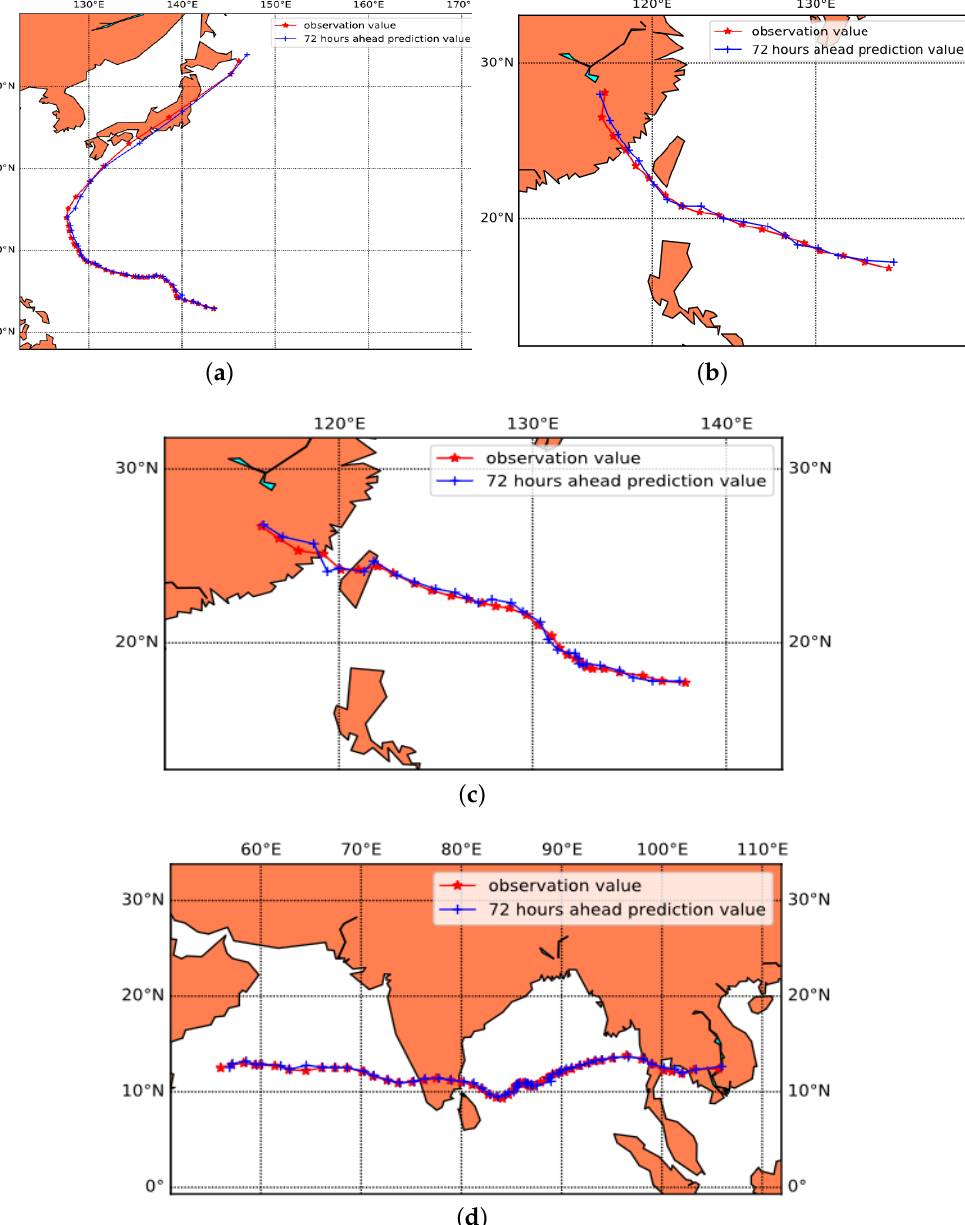
Figure 8. Seventy-two hour forecast results. ( a ) Track prediction of Typhoon Tip. ( b ) Track prediction of Typhoon Meranti. ( c ) Track prediction of Typhoon Dujuan. ( d ) Track prediction of Typhoon